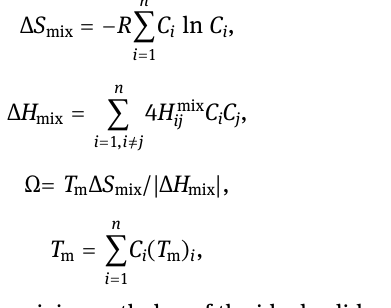
mix is the mixing enthalpy of the ideal solid solu - where H ij tion of the binary alloy system, Ω indicates the speci fi c ratio of mixing entropy and mixing enthalpy, T m repre - sents the theoretical melting point of the alloy system, and ) ( T i m represents the melting point of the component.